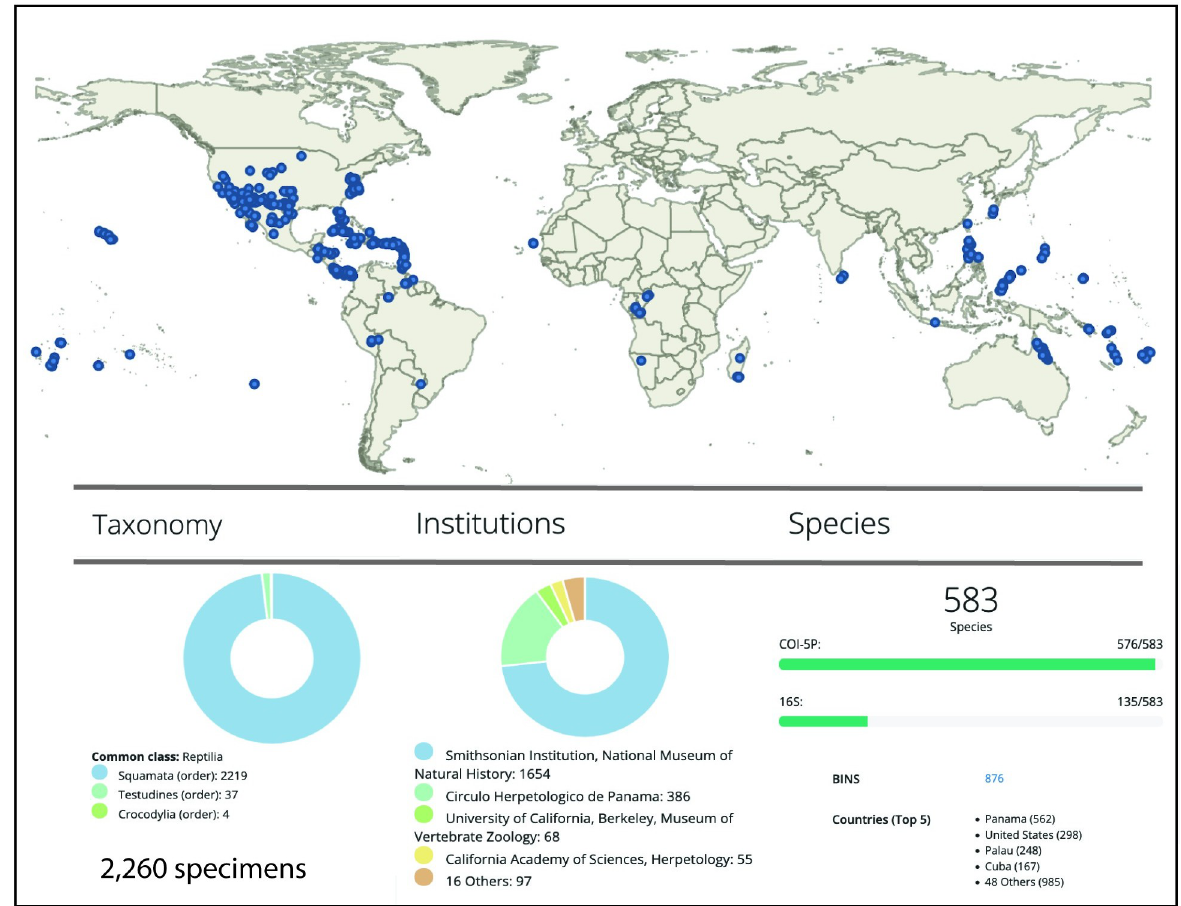
Fig 1. Distribution and summary data for sequence samples produced in this study. Upper: World map (1:250 million) showing geographic distribution of specimens sequenced in this study. Lower: left chart shows the taxonomic breakdown of specimens sequenced; middle chart shows institutions housing the voucher specimens; right chart shows the number of currently recognized species (for both COI and 16S markers), the number of Barcode Index Numbers (BINs) represented by COI sequences, and the number of specimens per country, for the top five countries.